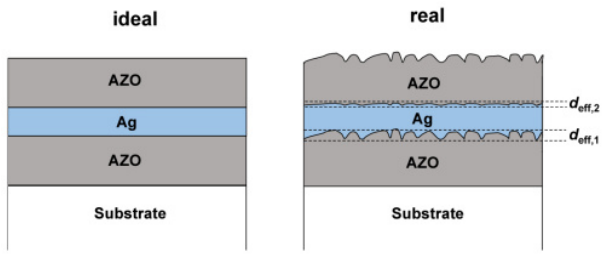
Figure 2. The ideal interfaces and real interfaces [18].